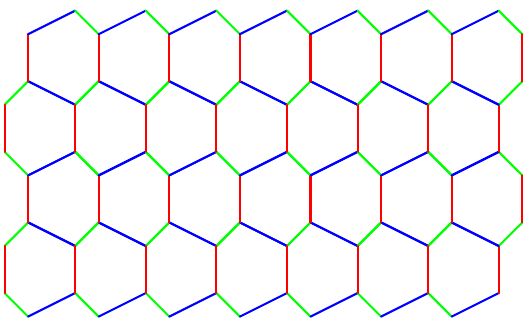
Fig. 46: Hexagons are the same but odd rows are reflected.